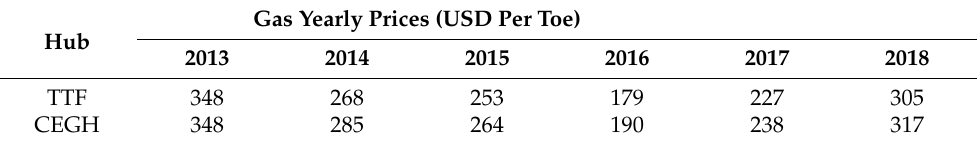
Table 8. Actual values—yearly gas price results (in USD per tons of oil